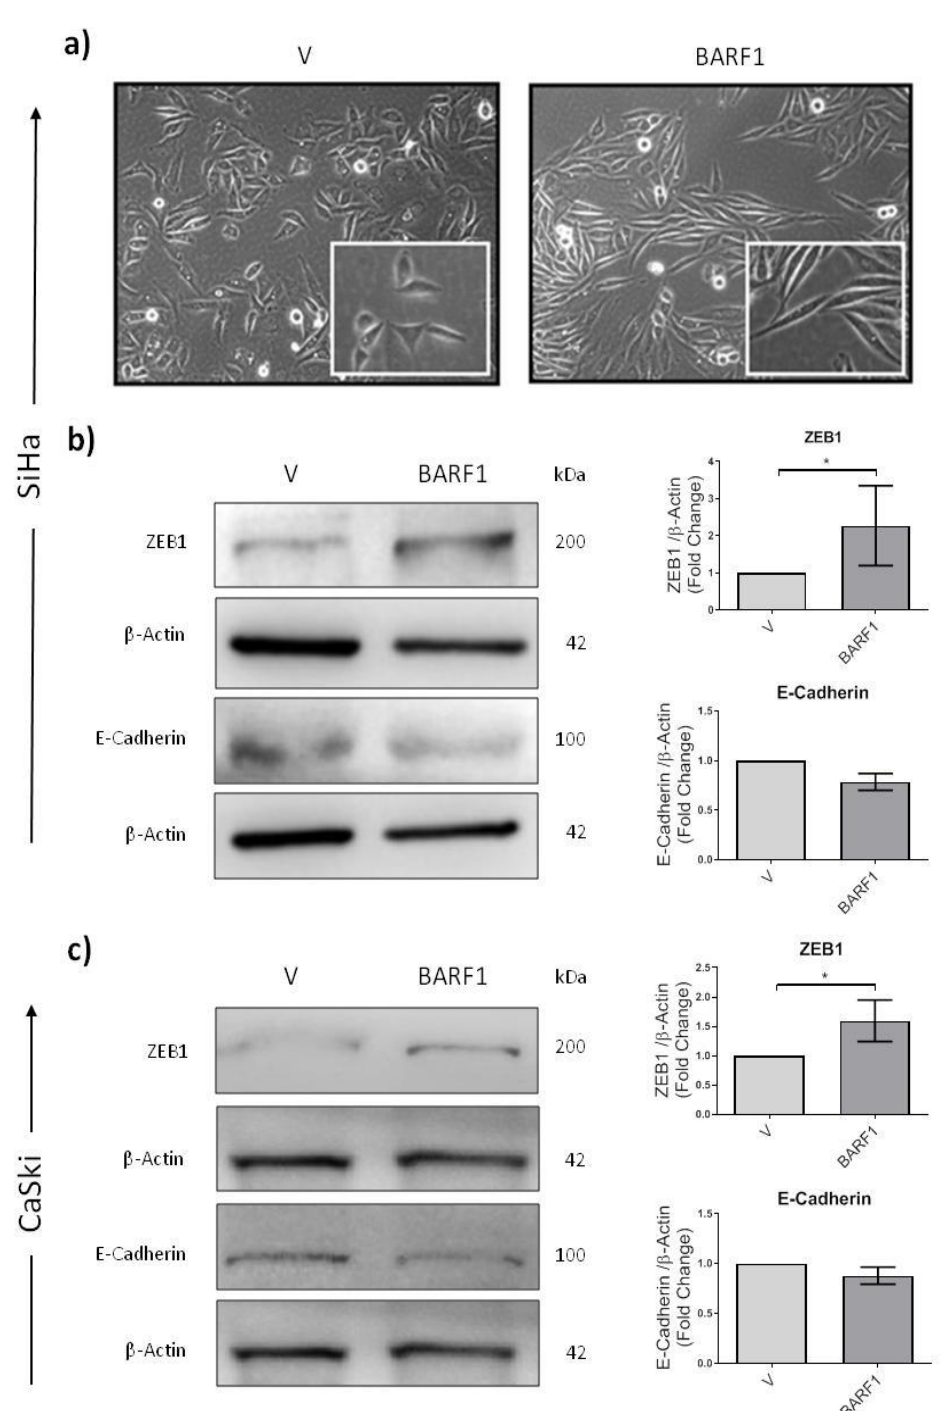
Figure 3. BARF1 promotes epithelial to mesenchymal transition in cervical cells. ( a ) Morphological changes characterized by the appearance of spindle-shaped cells were observed in SiHa cells stably transfected with BARF1 compared to empty vector-transfected cells. Analysis of ZEB1 and E-cadherin protein levels in SiHa and CaSki cells transfected with BARF1 or empty vector ( b , c , left ). A significant increase in the expression of ZEB1 was evidenced in BARF1-expressing SiHa and CaSki cells compared to empty vector-transfected cells ( b , c , right ) (* p = 0.050, for both). A decrease in E-cadherin was also evidenced in BARF1 transfected cells, but not statistically significant. Densitometric analyses of three independent assays normalized against β -actin were plotted. Data are presented as mean ± SEM.